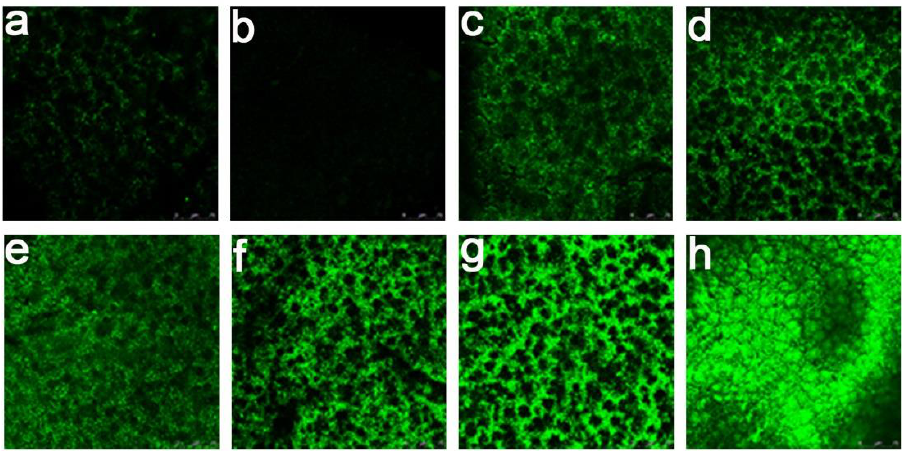
Figure 4. Confocal laser scanning microscopy (CLSM) pictures of the membranes’ surfaces after interaction with RCA 120 -FITC: ( a ) MPPM, ( b ) the POEGMA-modified MPPM (POEGMA GD = 350 µ g / cm 2 ), and ( c ~ h ) the galactose-modified MPPM (POEGMA GD = 350 µ g / cm 2 , glycosyl BD = 0.08 nmol / cm 2 , 0.44 nmol / cm 2 , 0.80 nmol / cm 2 , 1.60 nmol / cm 2 , 3.63 nmol / cm 2 , 5.41 nmol / cm 2 ). All experiments were repeated three times.